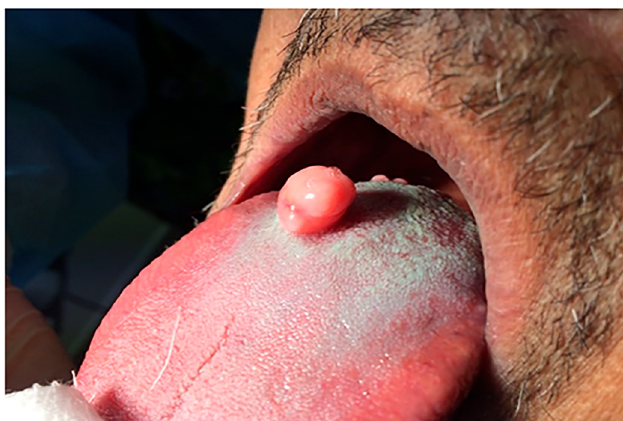
Fig. 1. Intraoral photograph showing a yellowish-pink nodule on the dorsum of the tongue, anterior to circumvallate papillae.